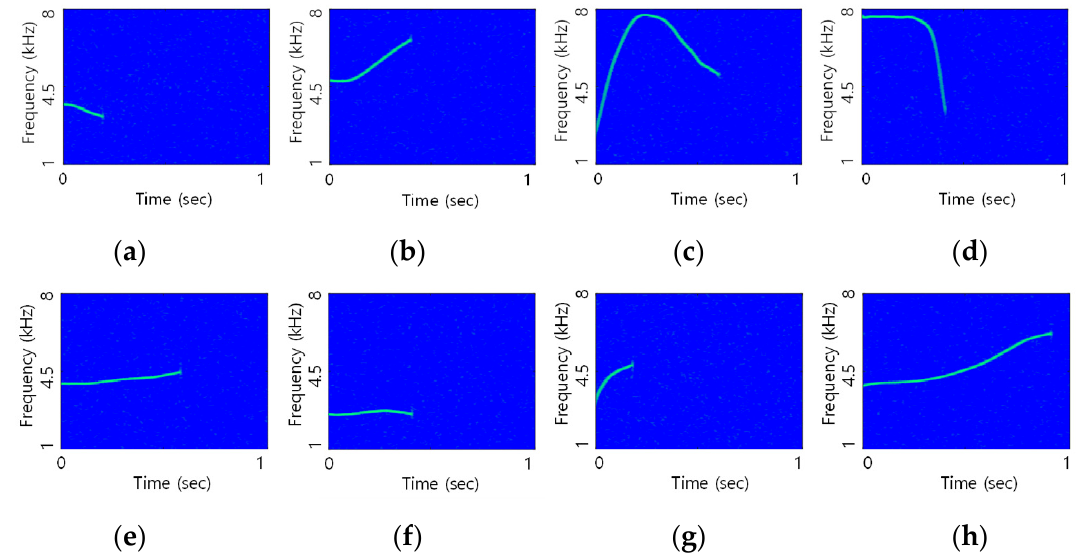
Figure 8. Whistle for the 2nd step DoM assessment (a) moderate change, (b) moderate change, (c) dramatic change, (d) dramatic change, (e) flat, (f) flat, (g) dramatic change, (h) moderate change.